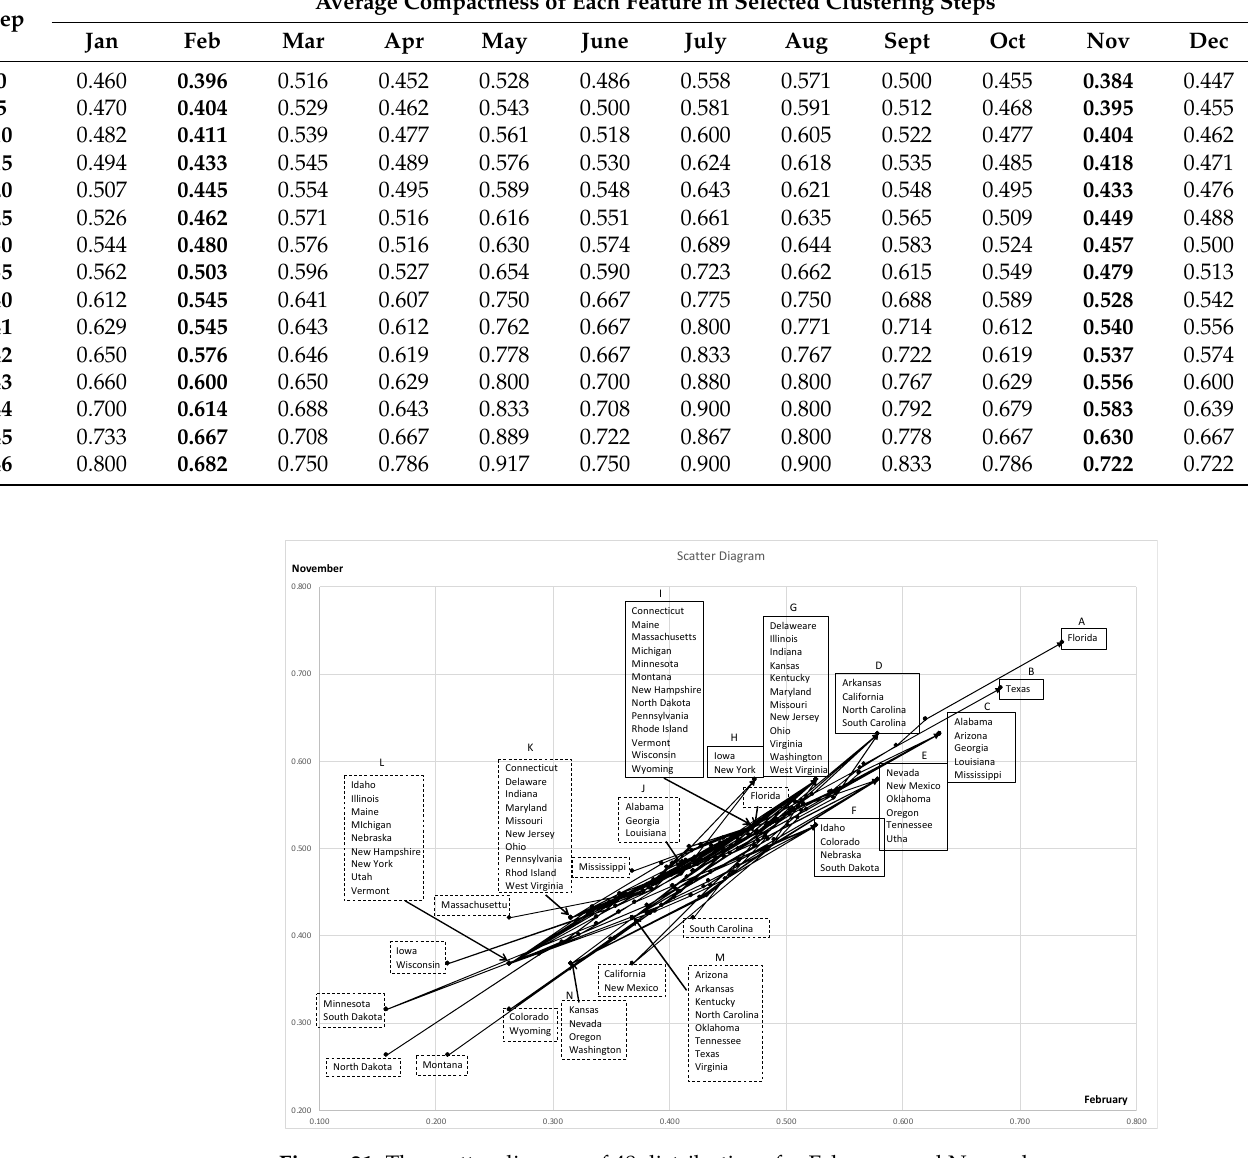
Table 11. The average compactness in selected clustering steps.